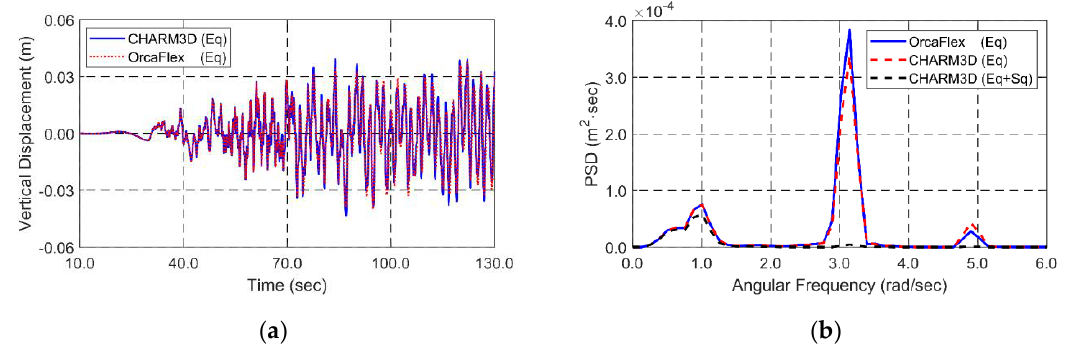
Figure 13. Time histories (without seaquake) ( a ) and spectra ( b ) of vertical tunnel responses at the middle location under seismic excitations.